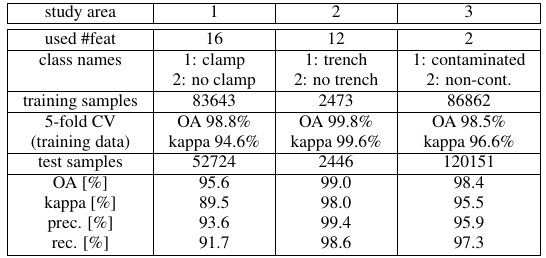
Figure 6. Study area 3: (a) Normalized height map and local component of the gamma spectrometer measurements [µSv/h]; (b) Normalized height map and classification result for class ”contaminated”, class probability values > 99% Table 3. Overview of the RF classification parameters and results study